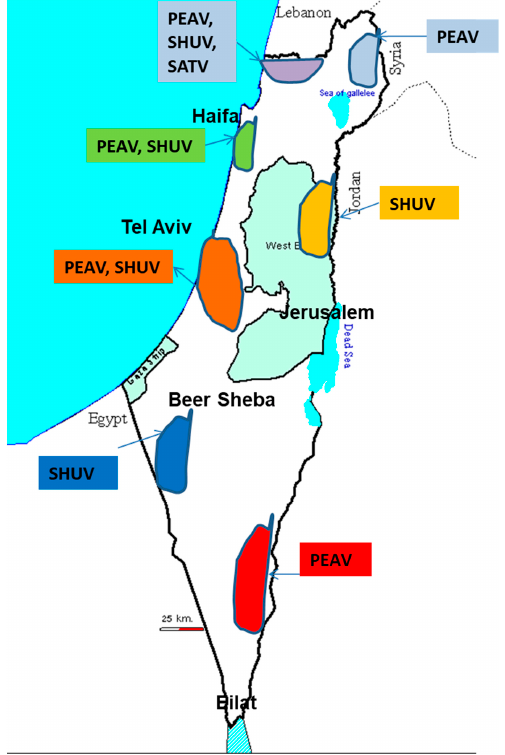
Figure 6. This figure shows the Simbu infected sites detected by genomic tests between 2016 and 2019. PEA, SHU, SAT: Peaton, Shuni, Satuperi viruses, respectively. (Schmallenberg virus is not shown. See Figure 7). Viruses 2021 , 13 , x FOR PEER REVIEW